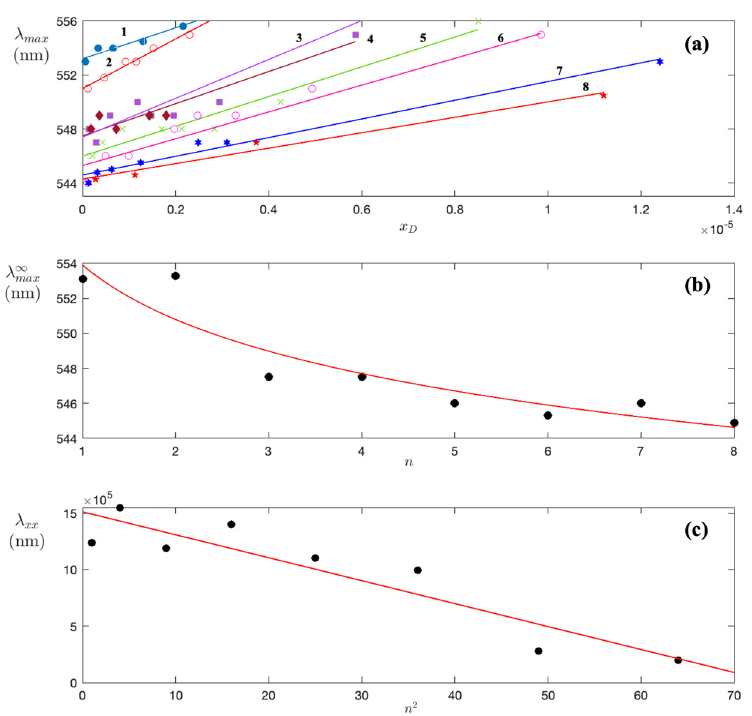
Figure 4. ( a ) The wavelength at the maximum of the absorption band in binary systems NR − H − (CH 2 ) n − OH (the n value is read directly on each line) as a function of mole fraction. ( b ) The wavelength of maximum absorption, extrapolated to infinite dilution as a function of the number of carbon atoms in the alkanol molecule. ( c ) Slope of the curve λ max ( x D ) as a function of the number of carbon atoms squared.